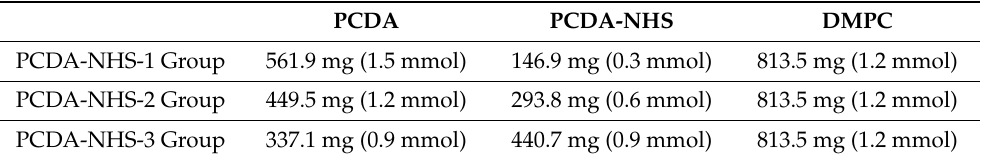
Table 1. Molar compositions of PCDA-NHS groups. Each PCDA-NHS group consists of different molar ratios of PCDA, PCDA-NHS, and DMPC. The PCDA-NHS-1 group has a 10% molar concentra- tion of PCDA-NHS, whereas the PCDA-NHS-2 and PCDA-NHS-3 groups have a 20% and 30% molar concentration of PCDA-NHS,